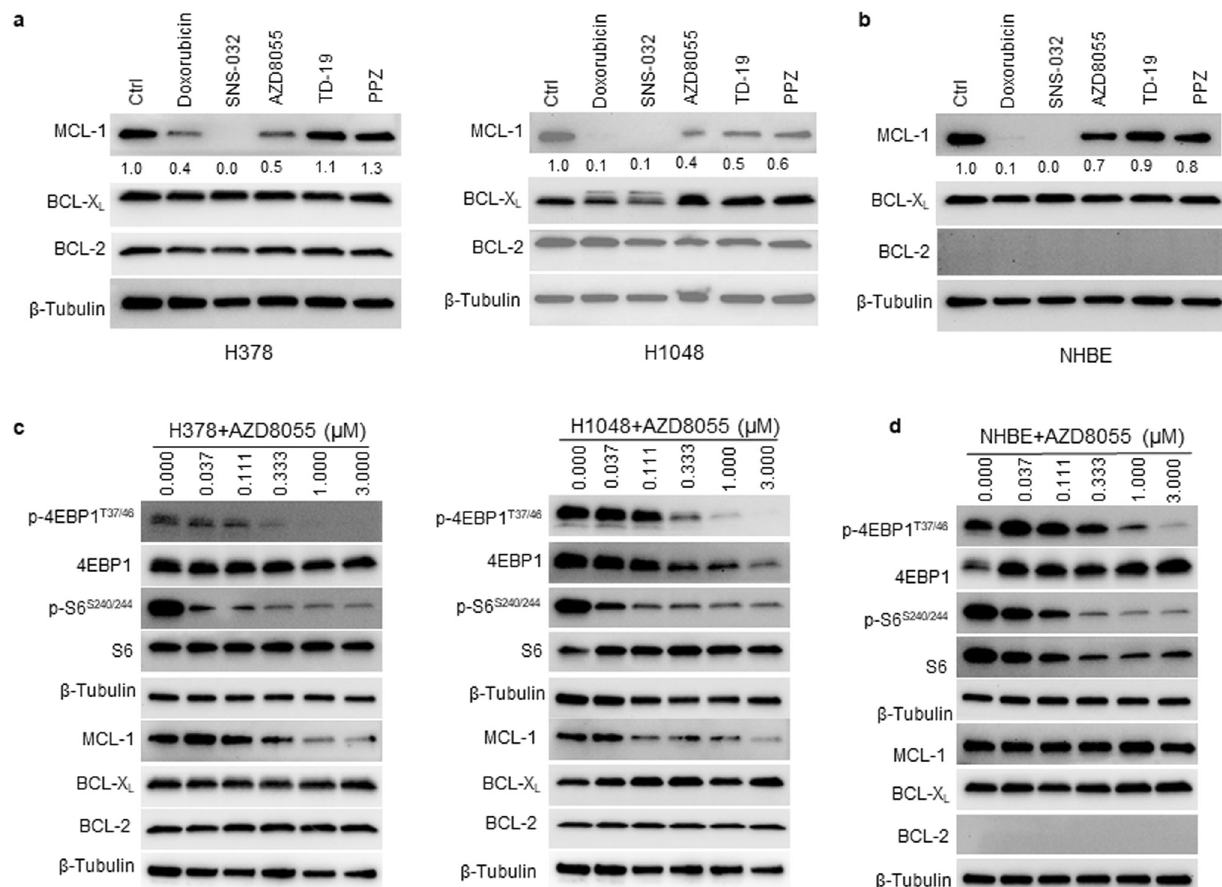
Fig. 3 mTOR inhibitor AZD8055 selectively suppresses MCL-1 expression in tumor cells. a , b Immunoblot analyses of MCL-1, BCL-X L, and BCL-2 in SCLC H378 and H1048 cell lines ( a ) and NHBE cells ( b ) after they were treated with indicated agents (1 µM each) for 24 h. Normalized densitometric values for MCL-1 blots are shown underneath. c , d Immunoblot analysis of mTOR substrates (p-4EBP1 and p-S6), MCL-1, BCL-X L , and BCL-2 after 24 h treatment with indicated concentrations of AZD8055 in H378 and H1048 SCLC cell lines ( c ) and NHBE cells ( d ). The uncropped immunoblot images related to this fi gure are provided in the “ Supplemental Material ” fi